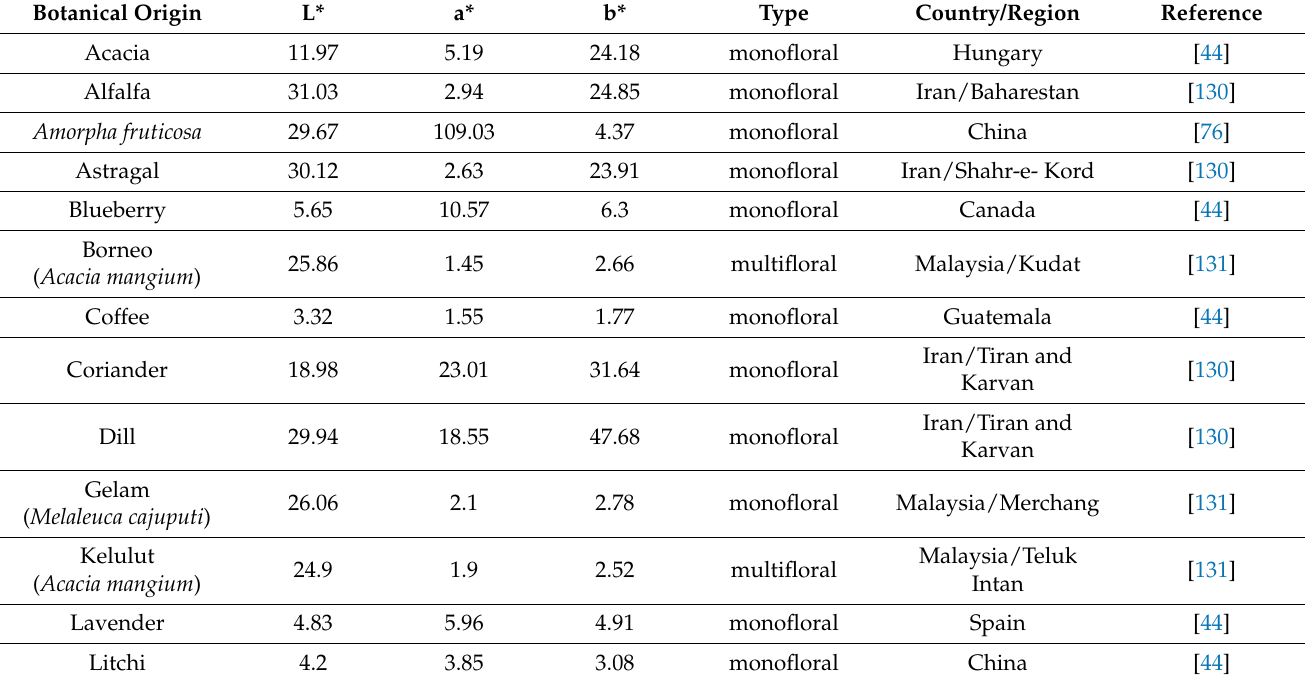
Table 3. L*, a*, b* values for monofloral and multifloral